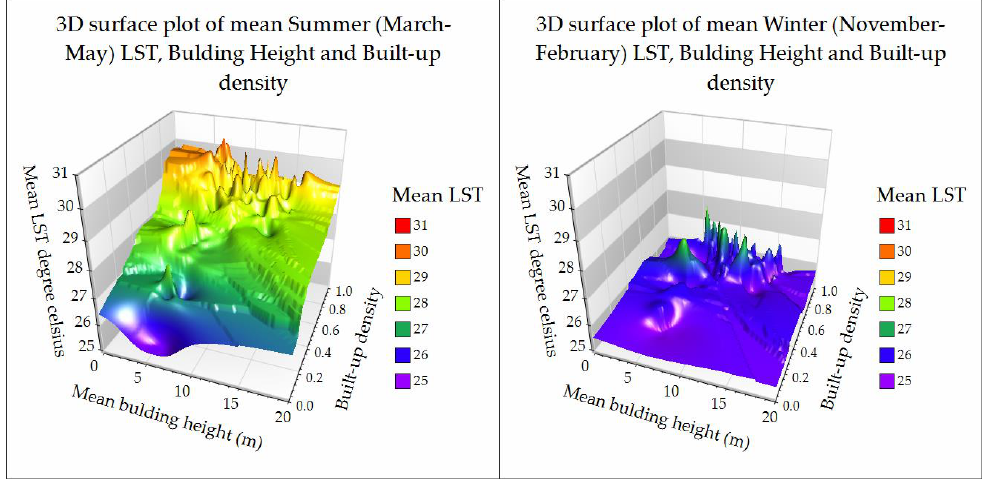
Figure 19. 3D surface plot of LST, building height, and built-up density. Table 5. LST characteristics of di ff erent landscape patterns of the built-up